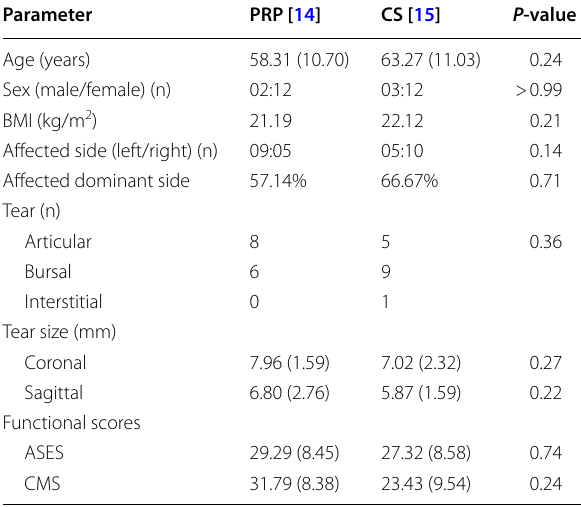
Age, tear size, and functional scores are represented as mean (standard deviation) PRP platelet-rich plasma, CS corticosteroid, ASES American Shoulder and Elbow Surgeons Shoulder score, CMS Constant–Murley score